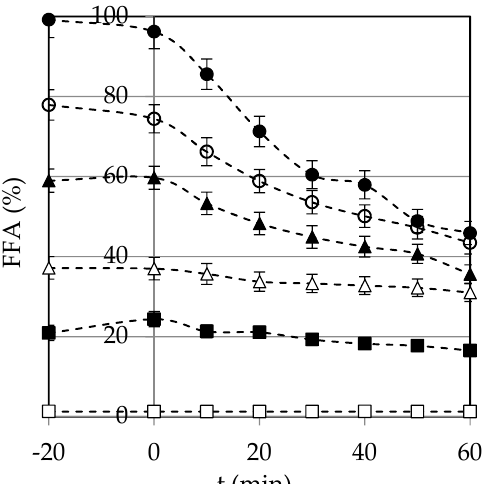
Figure 3. Glycerolysis of mixtures of linoleic acid with 0% ( ● ), 20% ( ○ ), 40% ( ▲ ), 60% ( ∆ ), 80% ( ■ ), and 100% ( □ ) lampante olive oil (mean ± SD, n = 2).